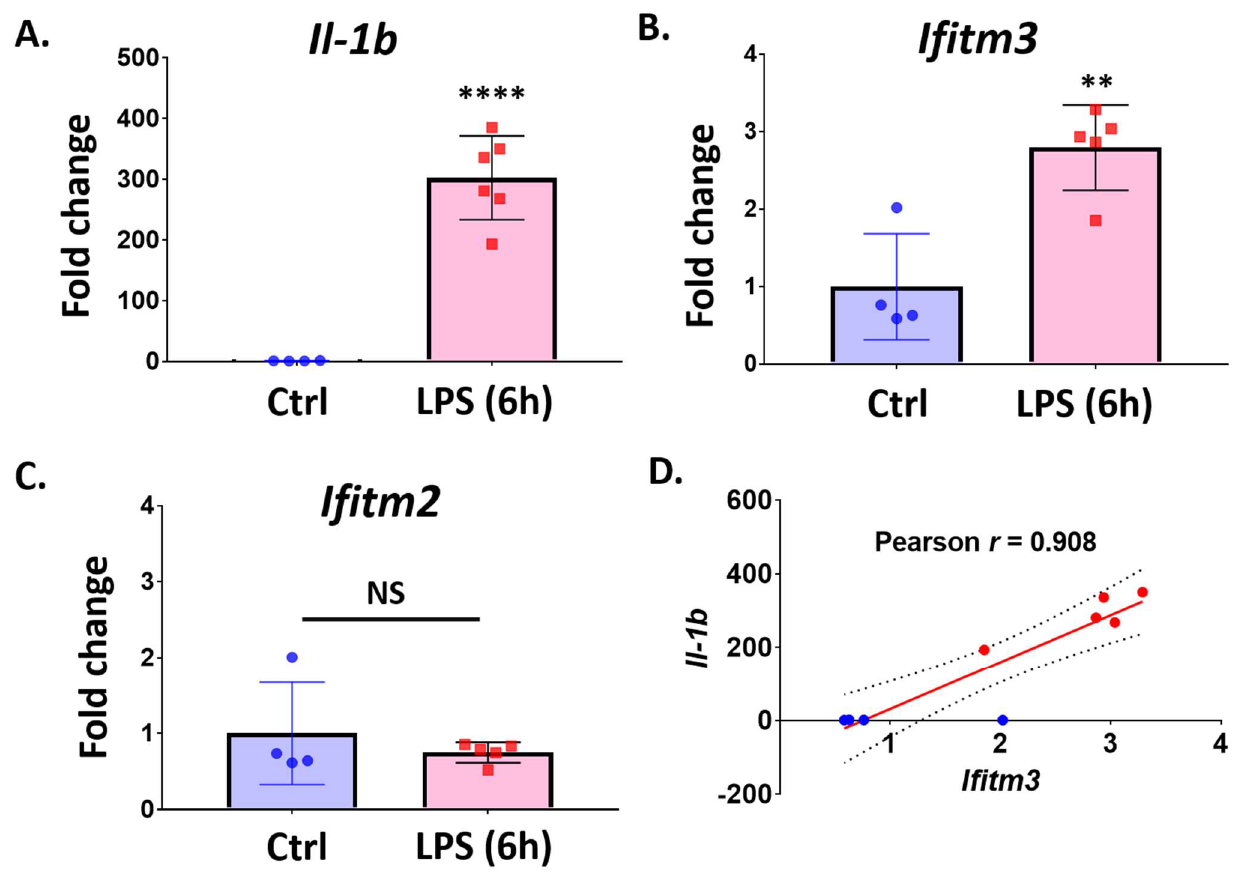
Figure 4. Ifitm3 expression is induced by LPS treatment in primary microglia. Primary microglia were treated with LPS (10 ng/mL) for 6 h. qRT-PCR was performed to measure gene expression for Ifitm3 and other pro-inflammatory cytokines genes. ( A ) Il1b level was significantly increased by LPS treatment ( n = 4–6, **** p < 0.0001 compared to control, two-tailed unpaired Student’s t -test). ( B ) Ifitm3 level was significantly increased by LPS treatment ( n = 4–5, ** p < 0.01 compared to control, two-tailed unpaired Student’s t -test). ( C ) Ifitm2 level was not significantly changed by LPS treatment ( n = 4–5). ( D ) Correlation analysis revealed a close correlation between Ifitm3 and Il1b expression in primary MG treated with LPS (r = 0.908).